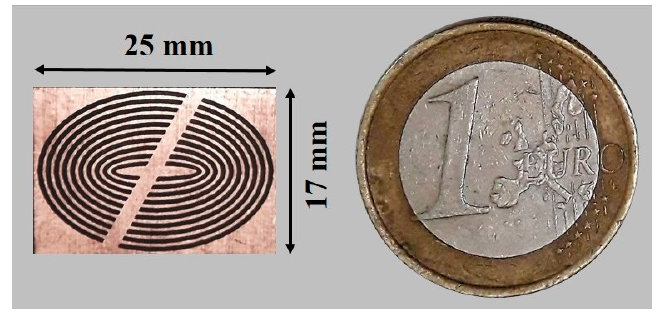
Figure 8. Proposed tag fabricated model.